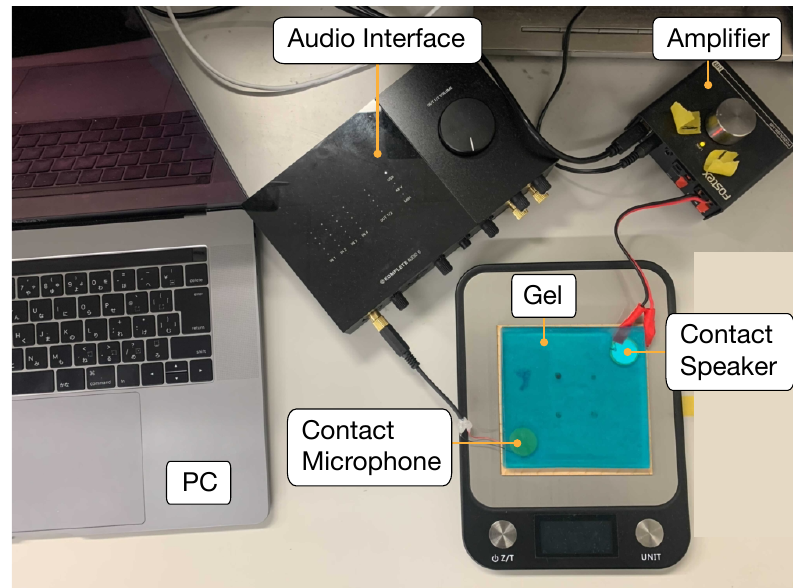
Figure 4. Implemented device.